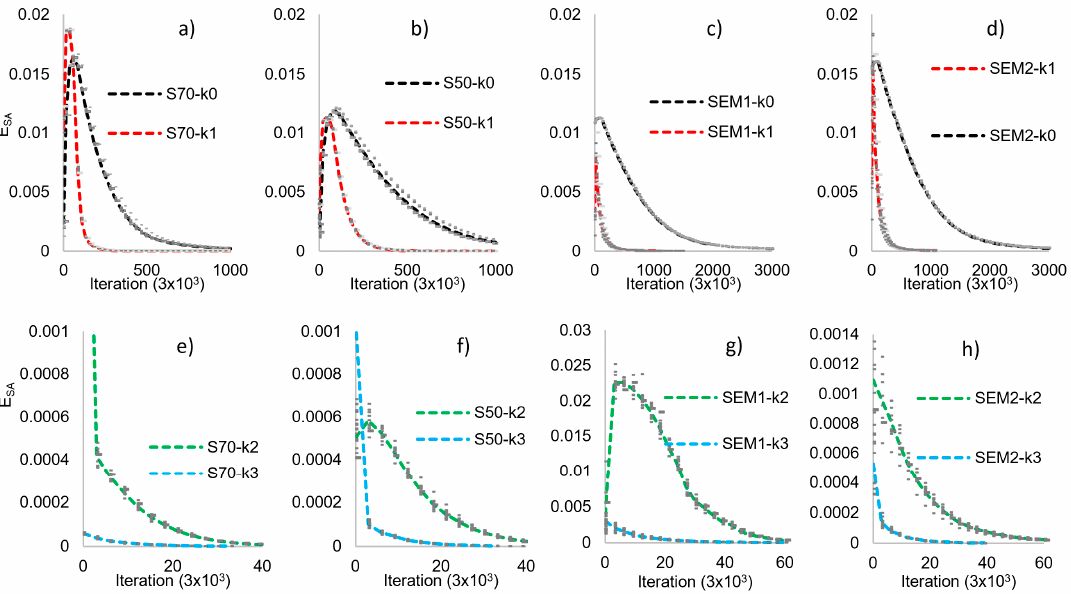
Figure 3. SA error (or energy) for each ω realization, k -th decimation, and ensembles for the studied materials. ( a – d ): k0 and k1 decimation and ( e – h ): k2 and k3 decimation.